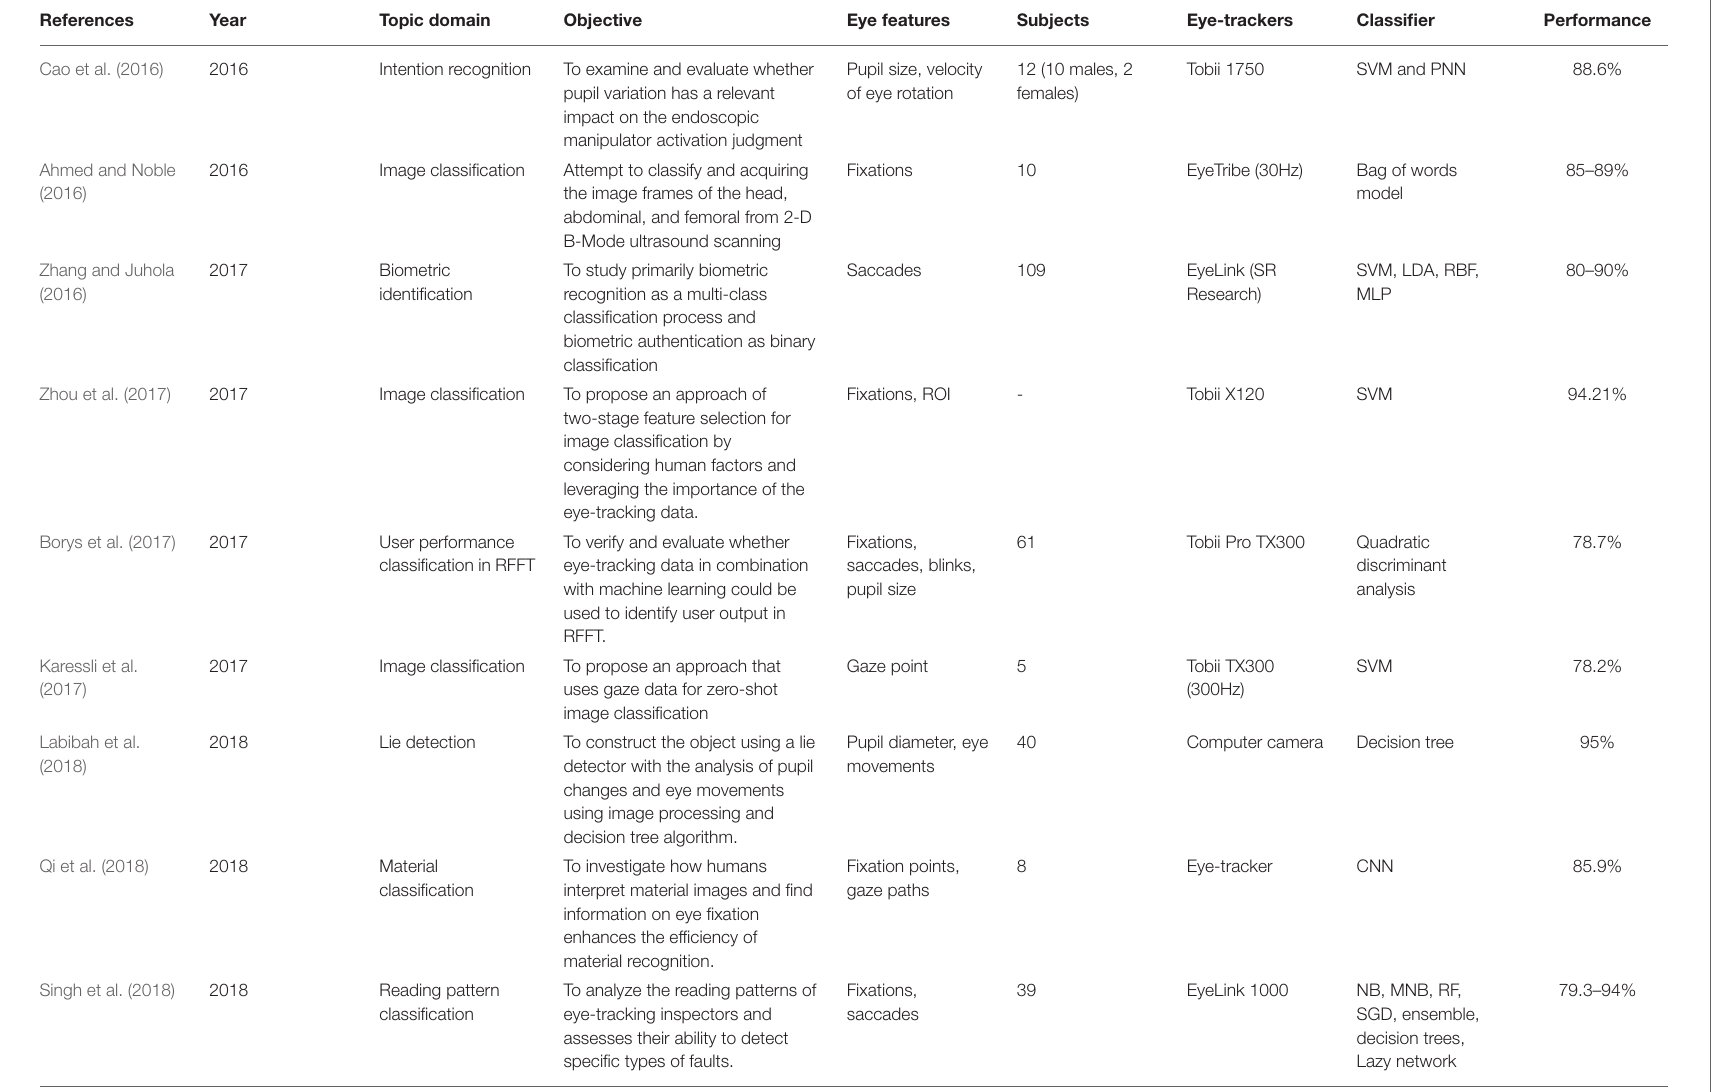
TABLE 1 | Summary of studies using eye